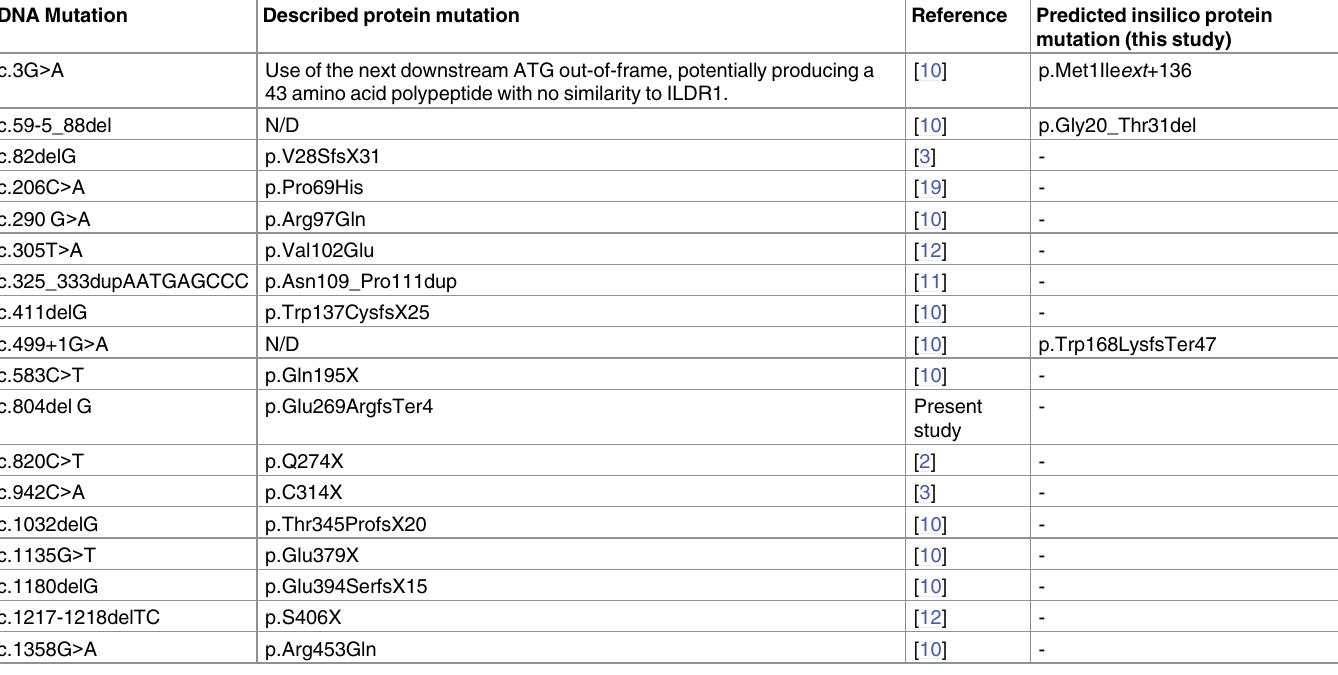
Table 1. ILDR1 reported mutations, described effectsand predicted consequences using insilico analysis.